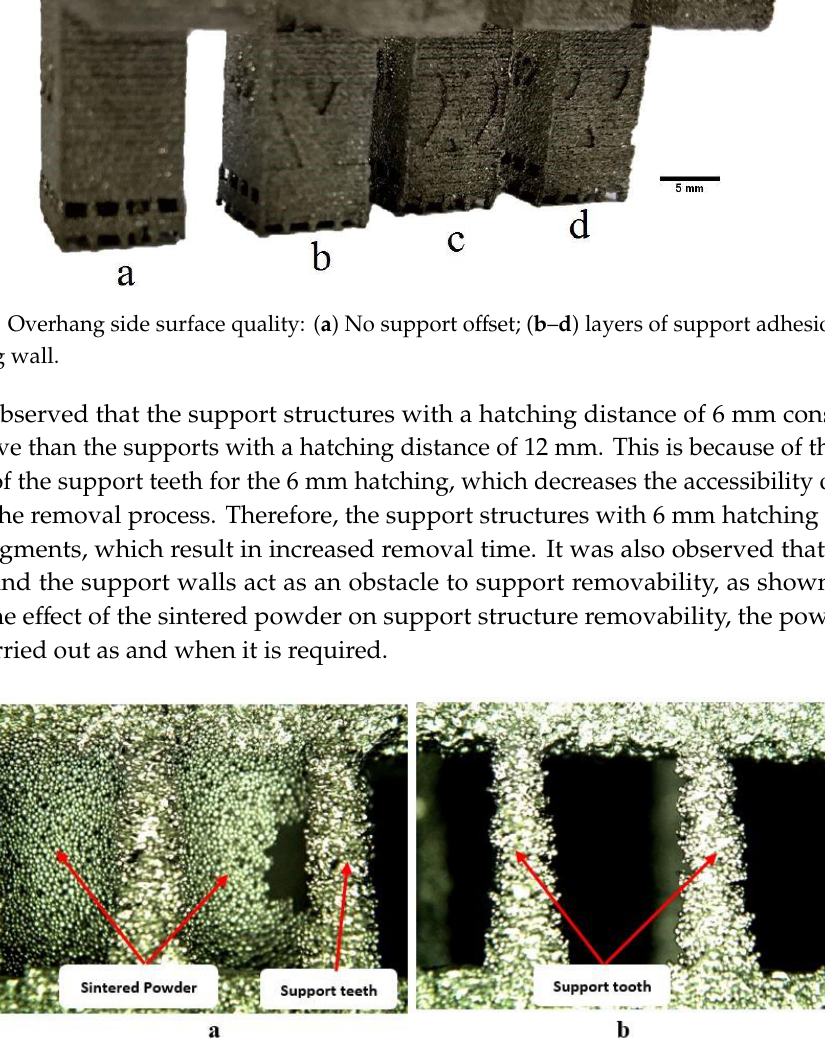
Figure 5. Support tooth structures: ( a ) before powder removal; ( b ) after powder removal.